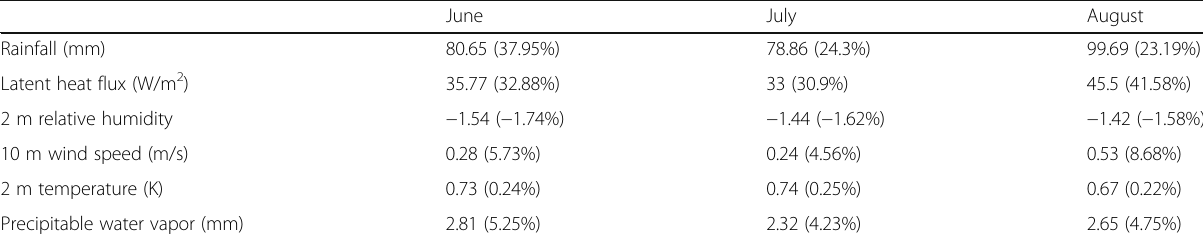
Table 1 Change in atmospheric variables due to a 1 K SST warming in the WSST region from 1982 to 2012. The actual values are shown with the percentage change relative to the mean CTL value (in parentheses). All variables were obtained from an average of the WSST region, except for rainfall, which was from the WPH